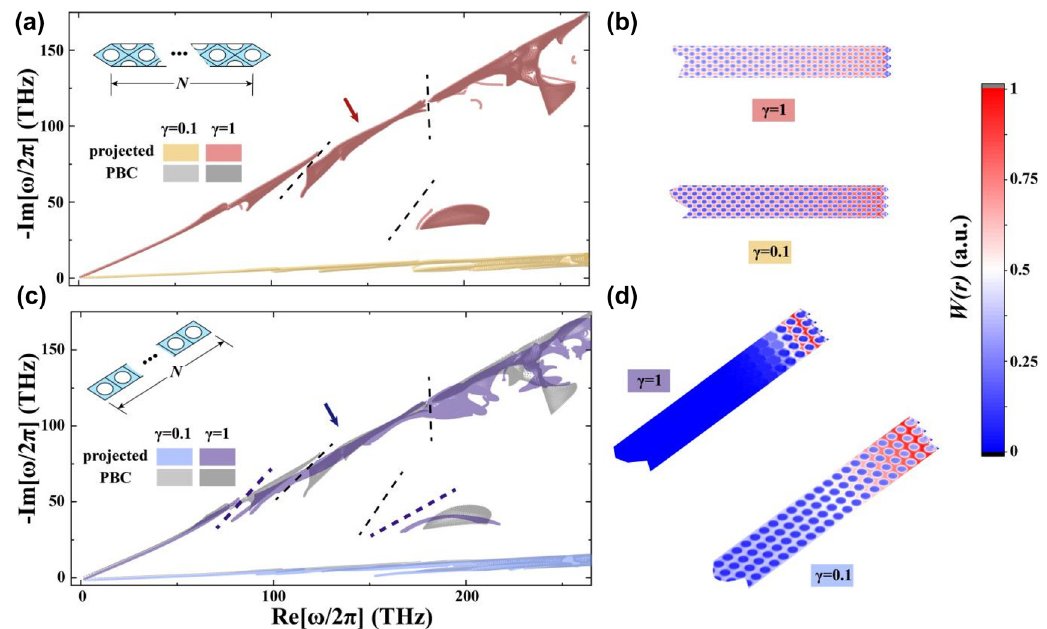
Figure 3: The projected band structure shown in the spectral area view for the crystalline interfaces perpendicular to (a) the route-1 and (c) the route-2/3. The inset in (a) and (c) schematically shows the simulation setup, and the lattice constants are 2 a sin ( 𝜃 ∕ 2) and a sin ( 𝜃 ), respectively. The spectral area with a dark (light) color represents the 𝛾 = 1 ( 𝛾 = 0.1) case. The gray color denotes the spectral area under PBC, and the black dashed lines denote the line gaps. The spatial distributions of W ( r ) corresponding to the configuration (a) and (c) are shown in (b) and (d), respectively. The eigenstates under consideration are indicated by the red and blue arrows. The number of unit cells N used in the calculation is